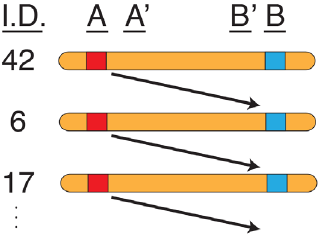
Figure 2. Schematic of the randomization method used to construct null distributions for patterns of LRLD. For each randomization, the identity numbers of the haplotypes are permuted randomly (left hand column). The disequilibrium between sites A and B is calculated using the allele at site A from one chromosome and the allele at site B from the following